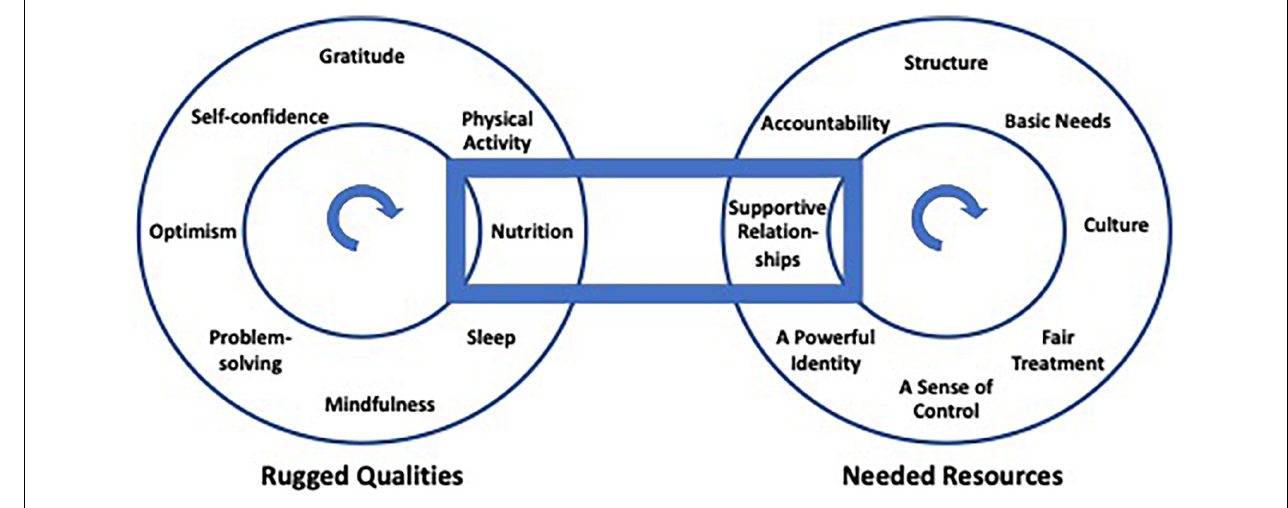
FIGURE 3 | Interaction between rugged qualities and